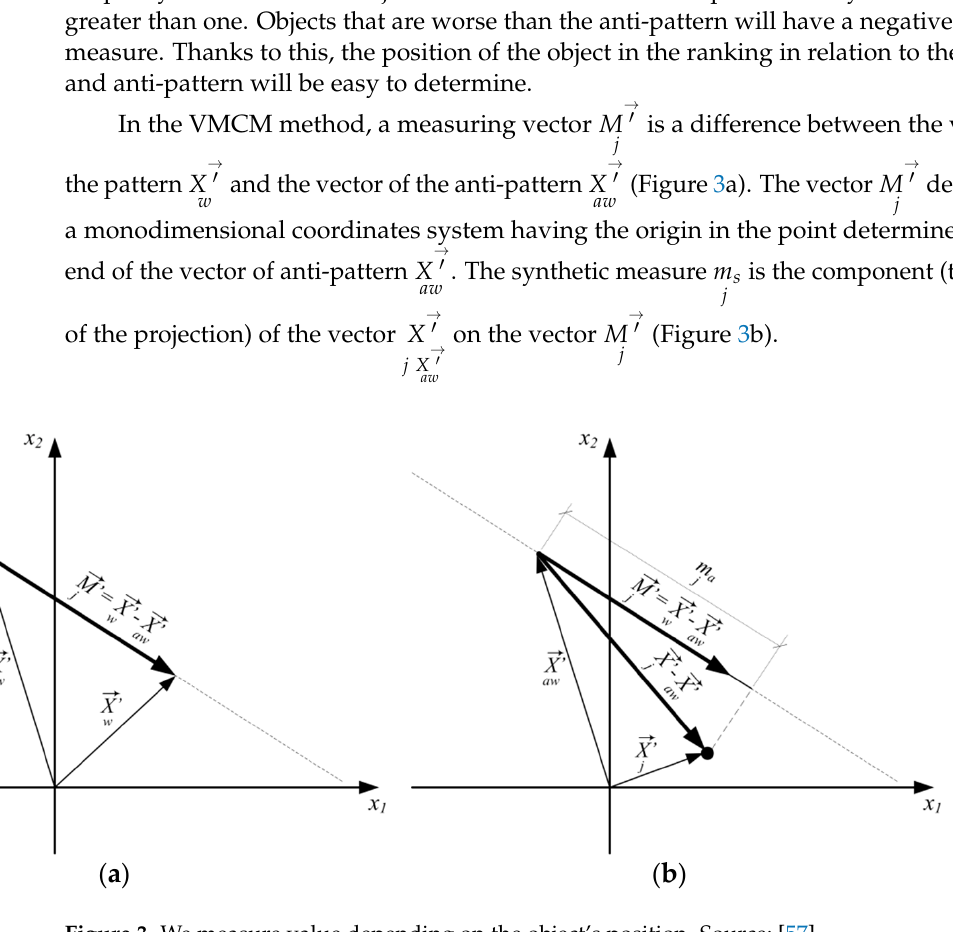
Figure 3. Measure value depending on the object’s position. Source: [64]. Figure 3. We measure value depending on the object’s position. Source: